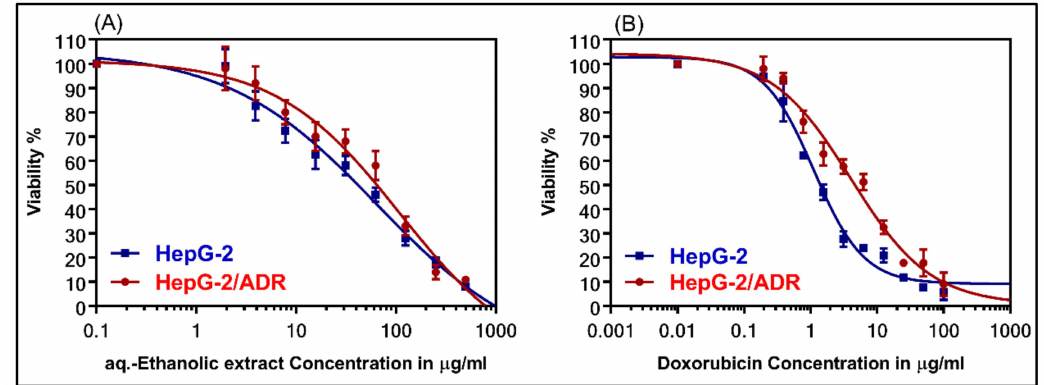
Figure 3. The dose-response curves of Suaeda vermiculata aq.-ethanolic extract: ( A ) aq.-ethanolic extract, and ( B ) doxorubicin (DOX) in wild-type HepG-2, and resistant HepG-2 / ADR